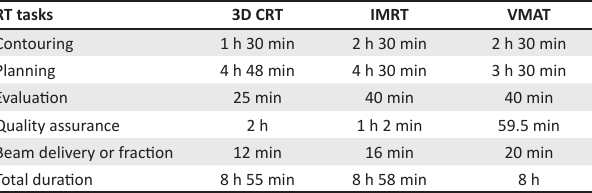
TABLE 6: Average treatment planning time and beam delivery time per fraction, as measured for each of the seven patients. RT tasks